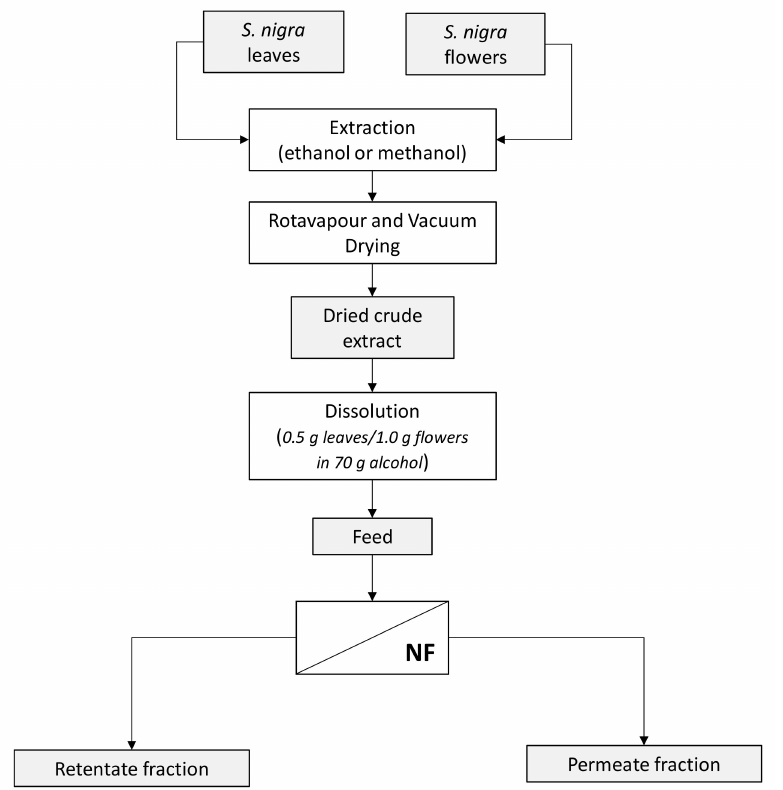
Figure 1. Extraction of S. nigra leaves and flowers and concentration of bioactive compounds by